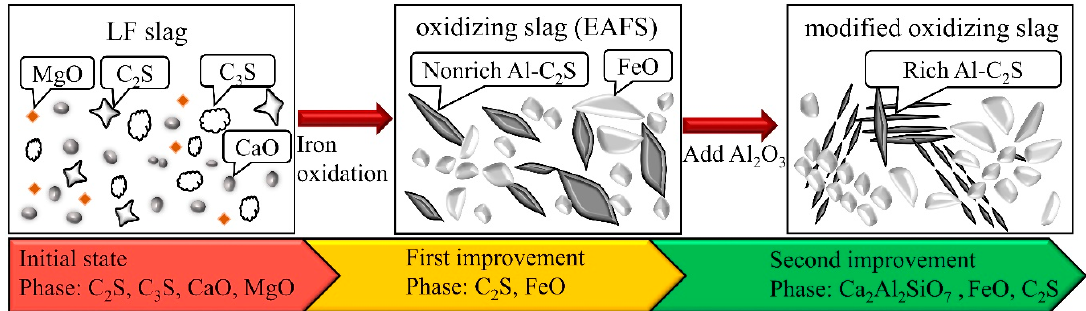
Figure 7. Samples identified on the CaO–40FeO–SiO 2 –Al 2 O 3 system at 1250 °C.